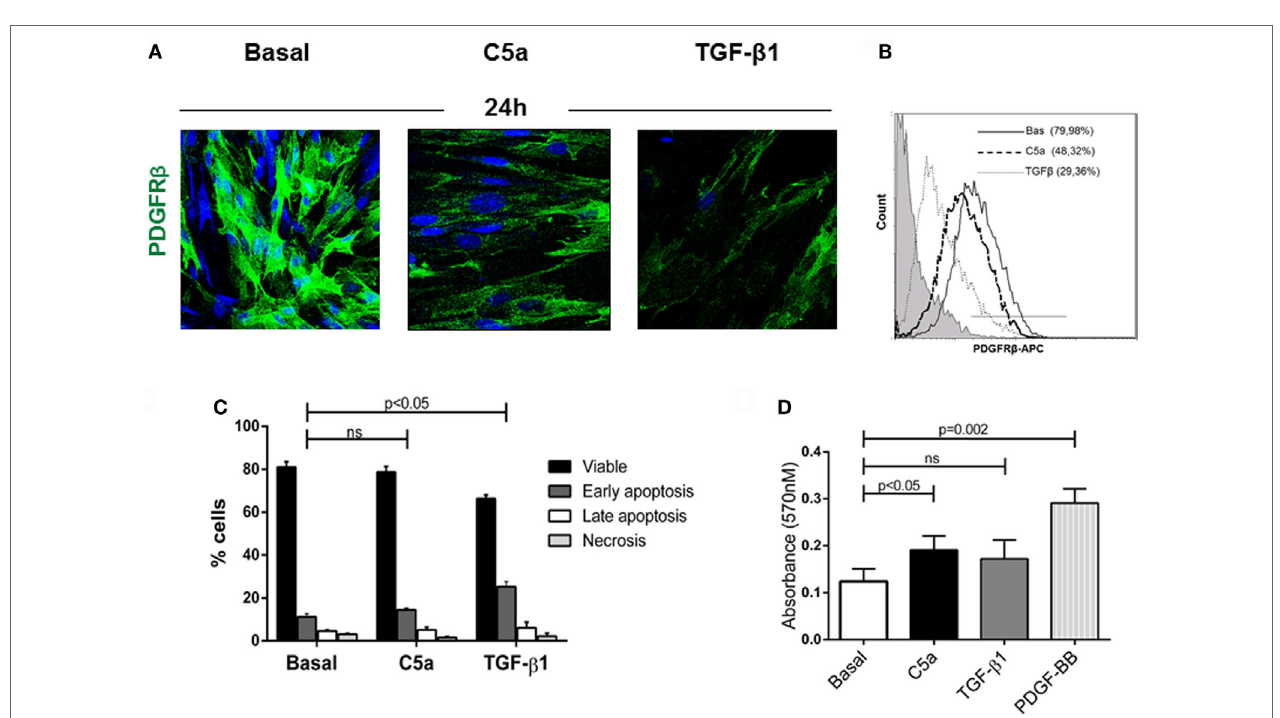
FigUre 5 | PMT is modulated by C5aR1 and associated with capillary lumen reduction 1 day after ischemia/reperfusion (I/R) injury. Renal I/R injury was performed for 24 h in C5aR1-deficient mice as showed in (a–c,i) and in a swine model treated with C1-INH as showed in (D–h) . (a) Confocal images showing interstitial peritubular capillaries pericytes in a mouse model of I/R injury co-labeled with PDGFR β (green) and α SMA (red). In the Wtype sham, PDGFR β + / α SMA + perivascular cells were barely detectable. After 24 h of I/R injury (b) , the number of PDGFR β + / α SMA + cells increased predominately at peritubular capillaries level. (c) C5aR1 − / − mice were protected from PDGFR β loss and α SMA increase. Results are expressed as median ± interquartile range (IQR) of the numbers of PDGFR β + / α SMA + cells/ high power fields (HPF) of five independent mouse for each group (i) . Magnification, 50 × . Representative IHC images of PDGFR β -stained renal biopsies used to measure the peritubular capillaries area (D,g) . After 24 h of I/R injury (e) , microvessels appeared constricted with a significant decrease in luminal diameter. (F) The treatment with C1-INH restored basal capillary area fraction. Scale bar, 100 µM. (g) Schematic panel showing the calculation of capillary lumen area using Image J Software. (h) Graph indicating the mean of capillary lumen area. Results are expressed as median ± IQR of the capillary area fraction (%), n = 3 for each